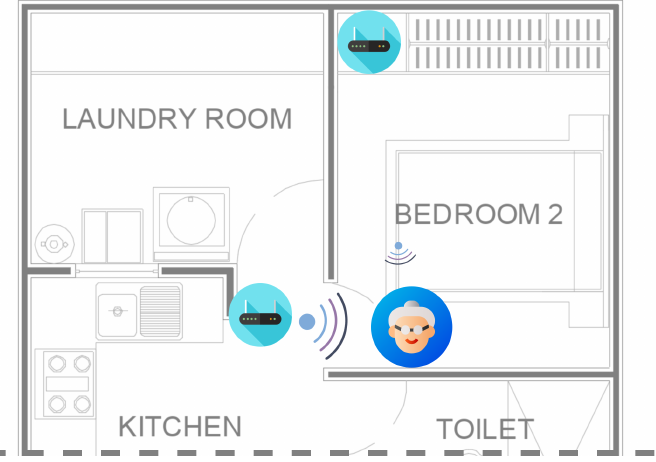
Figure 9. A possible scenario where the proximity method can fail.